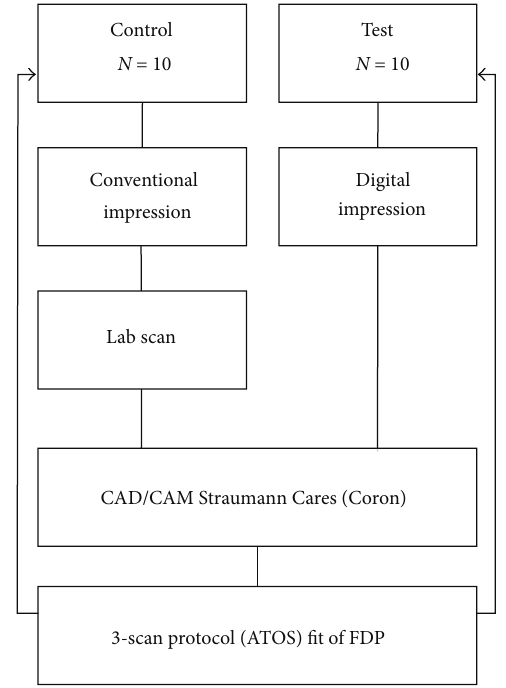
Figure 1: Study design comparing the fit of fixed dental prostheses produced with the conventional and digital impression